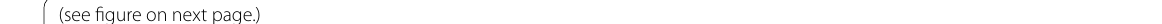
Fig. 4 SOX2OT promoted autophagy and relieved cell proliferation and fibrosis by inhibiting the Akt/mTOR pathway. Mouse mesangial cells were incubated with high glucose (HG) or normal glucose (NG). HG cells were transfected with pcDNA-SOX2OT or pcDNA-vector. a , f LC3 expression in HG cells after SOX2OT overexpression in the presence or absence of rapamycin was assessed by immunofluorescence. Scale bar: 50 μm. b Western blot analysis of LC3II, LC3I, Beclin1 and p62 in HG cells with SOX2OT overexpression. c , d Expression levels of p-Akt, Akt, p-mTOR, and mTOR in HG cells with SOX2OT overexpression in the presence or absence of rapamycin were determined using western blot assay. e Western blot analysis of LC3II/LC3I, Beclin1 and p62 in HG cells in response to SOX2OT overexpression in the presence or absence of rapamycin. g Western blot assay was implemented to detect expression of TGFβ-1, fibronectin, ASK1 and collagen IV in HG cells with SOX2OT overexpression in the presence or absence of rapamycin. h Expression of E-cadherin and N-cadherin detected by western blot assay in HG cells after SOX2OT overexpression in the presence or absence of rapamycin. GAPDH was used as a loading control in western blot analysis. Error bars represent the mean SD from three independent ± experiments. Rapa, rapamycin. *p < 0.05, **p < 0.01, ***p < 0.001, One-way-ANOVA followed by Newman–Keuls post hoc